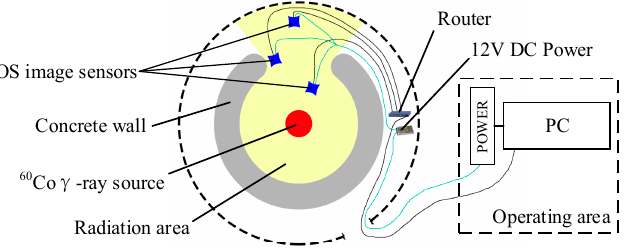
Figure 2. Schematic representation of 60 Co γ -ray experimental system.